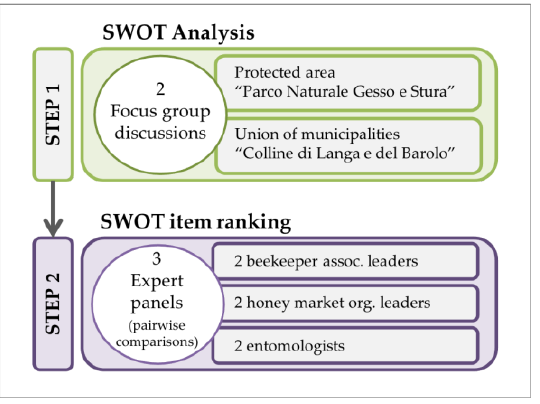
Figure 1. Diagram of methodological approach.